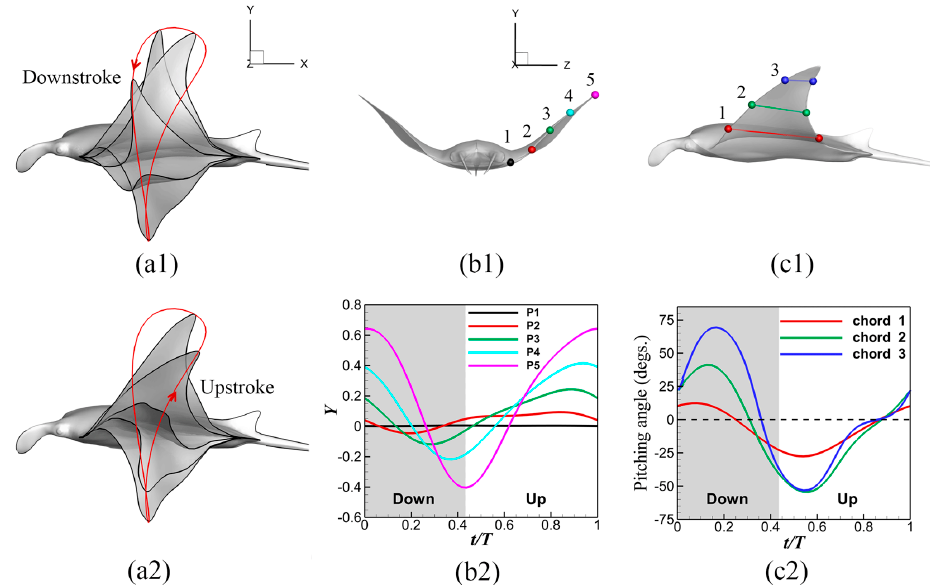
Figure 17. Lateral view of a manta’s flapping motion during ( a1 ) downstroke and ( a2 ) upstroke. The red line with an arrow is the tip trajectory; ( b1 ) Five marker points in the leading edge of the pectoral fin; ( b2 ) up and down displacement ( Y , normalized by body length) of the five marker points during a flapping cycle; ( c1 ) three chord lines at 0.3 (red), 0.6 (green) and 0.85 (blue) half-span on the pectoral fin; the pithing angle of these three chord lines during a flapping cycle.